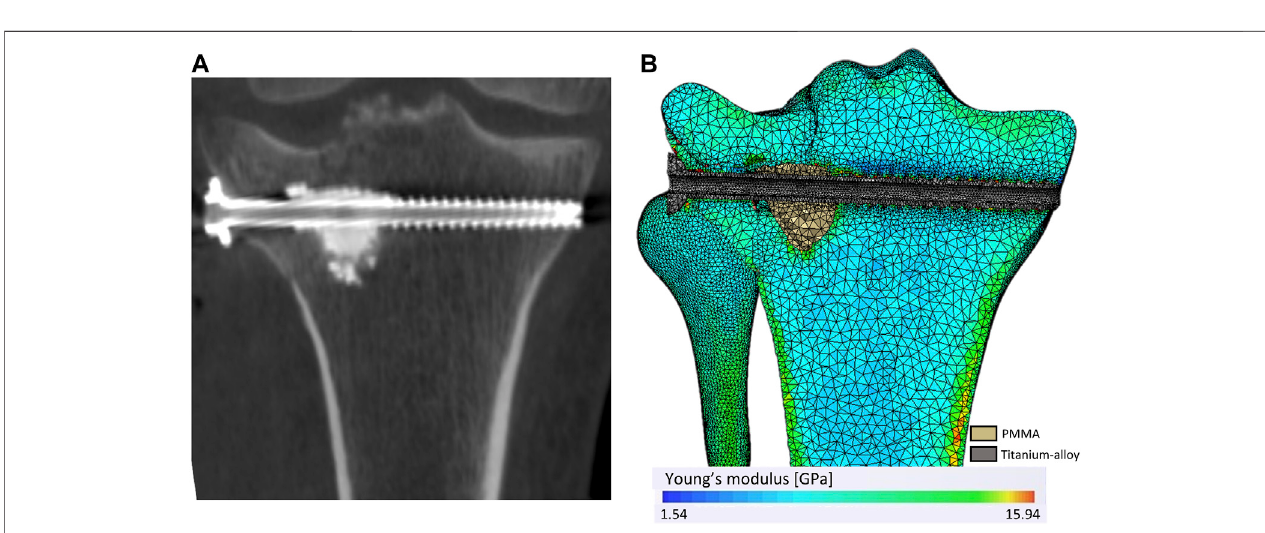
FIGURE 2 | Mesh and heterogeneous distribution of bone material properties. (A) A coronal plan of the 3D X-ray image. (B) The mesh and the material properties distribution according to the bone density observe through the 3D X-ray image.